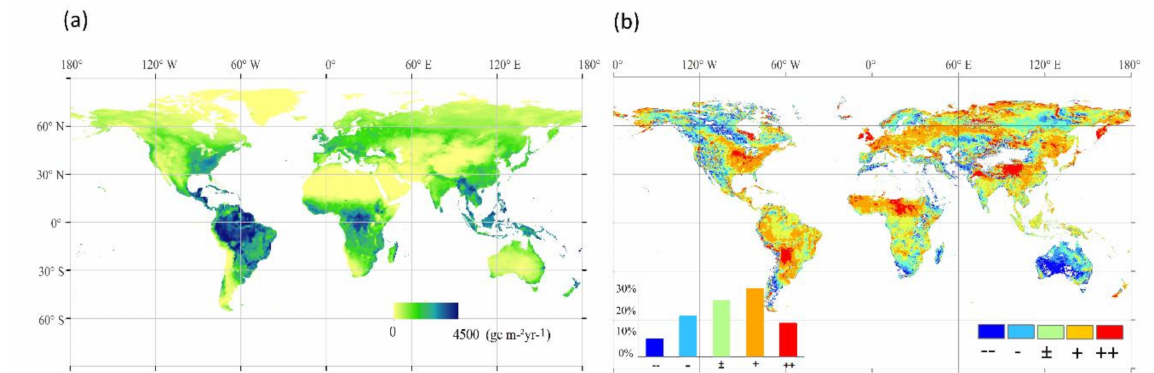
Figure 4. Consequences of biased input data on LUE-NDWI GPP at a global scale. ( a ) The mean annual GPP from 2000 to 2018 after data correction (reference Section 2.5). ( b ) The difference of mean annual GPP from 2000 to 2018, GPPuncorrected— GPPcorrected. Symbols indicate various levels of difference: ‘–’: − 50%–( − 30%), ‘-’: − 30%–( − 10%), ‘ ± ’: − 10%–10%, ‘+’: 10–30%, ‘++’: 30–50%. The inset bar chart shows the global distribution of the difference proportions.